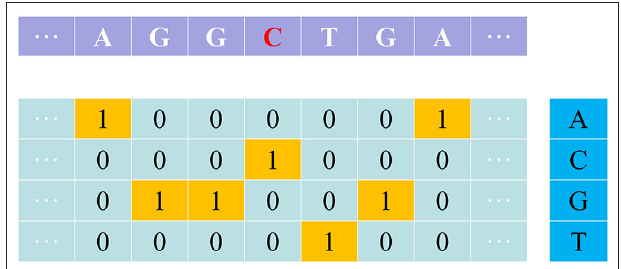
FIGURE 1 | An illustration showing the one-hot encoding